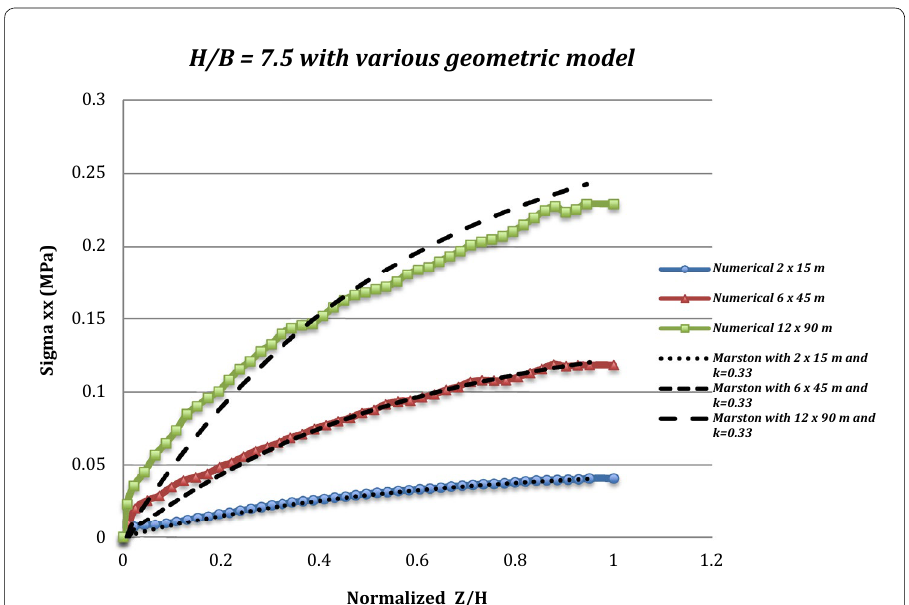
Fig. 14 Adjustment of the Marston analytical model with K 2 15, 6 45 and 12 90 m × × ×